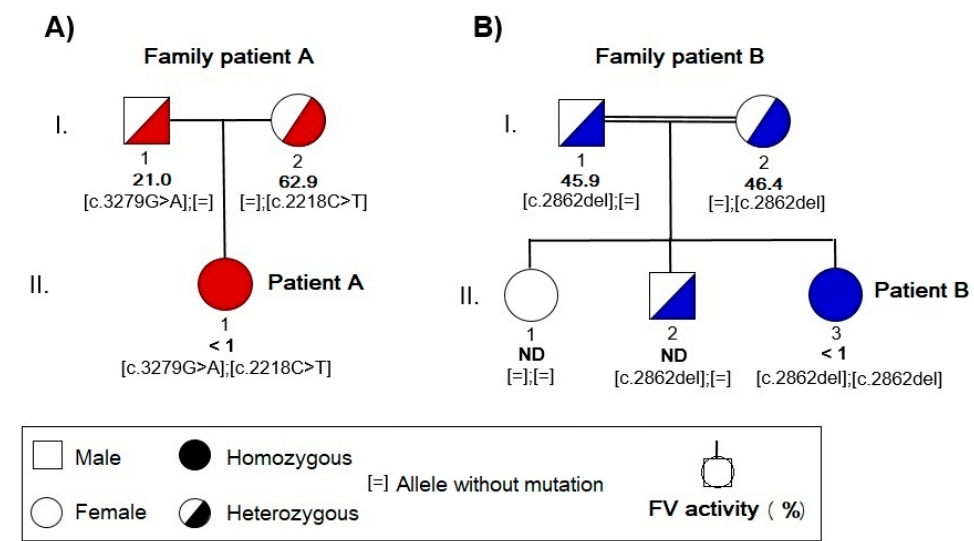
Figure 5. Family pedigrees of the FVa deficient Spanish and Pakistani families. FVa levels and segregation of the identified mutations are shown. ( A ) Patient A with FVa deficiency and two mutations in compound heterozygous state with familiar segregation ( c.3279G>A mutation inherited from her father and c.2218C>T from her mother). ( B ) Patient B with FVa deficiency and mutation in homozygous state, the c.2862del mutation inherited from both, father and mother .